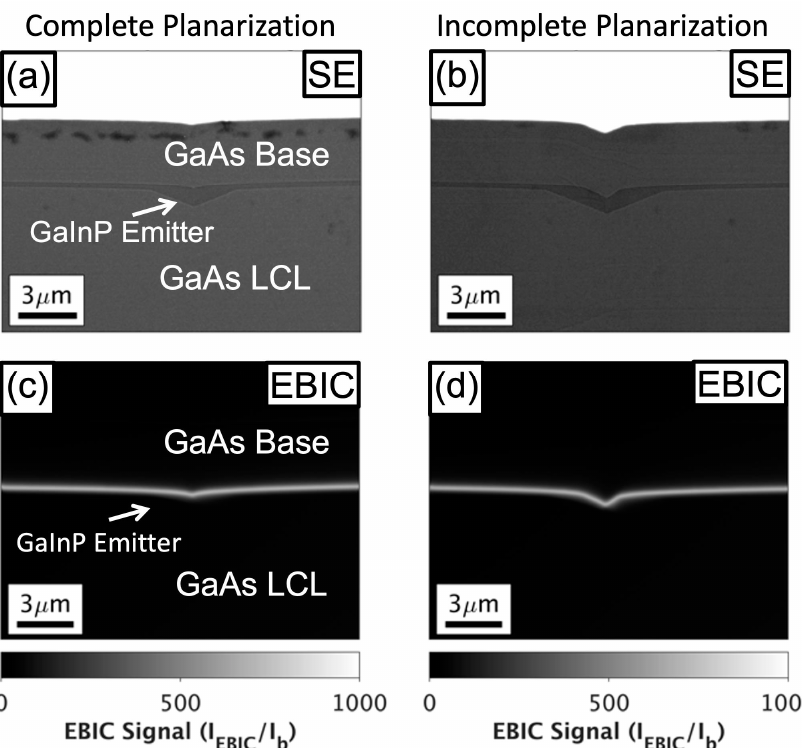
Figure 6. Secondary electron images of cross-sections cleaved through regions of ( a ) complete (blue circle, Figure 5b) and ( b ) incomplete (red circle, Figure 5b) planarization. ( c , d ) EBIC images captured in the same locations, which indicate the position of the junction.